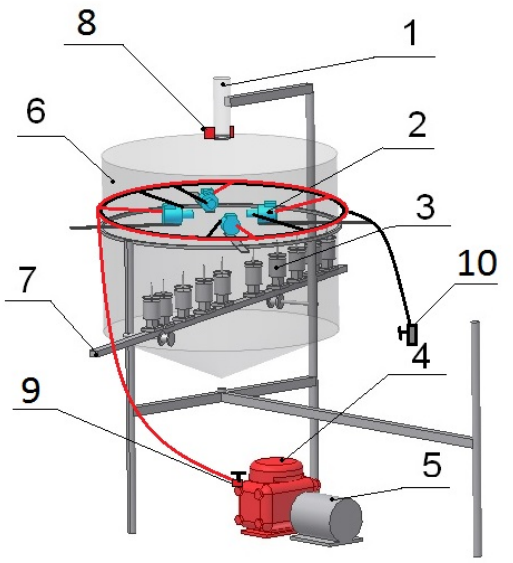
Figure 1. A diagram of the measuring facility with electronically controlled valves for dressing seed potato tubers. 1—pipe with optic sensor for guiding the potato fall path, 2—electromagnetic valve sprayer with cover, 3—spikes for spearing potatoes, 4—a diaphragm pump with a pressure valve, 5—electric engine, 6—bowl for collecting excess working liquid, 7—bar with spikes, 8—sensor, 9—overflow valve, 10—valve regulating